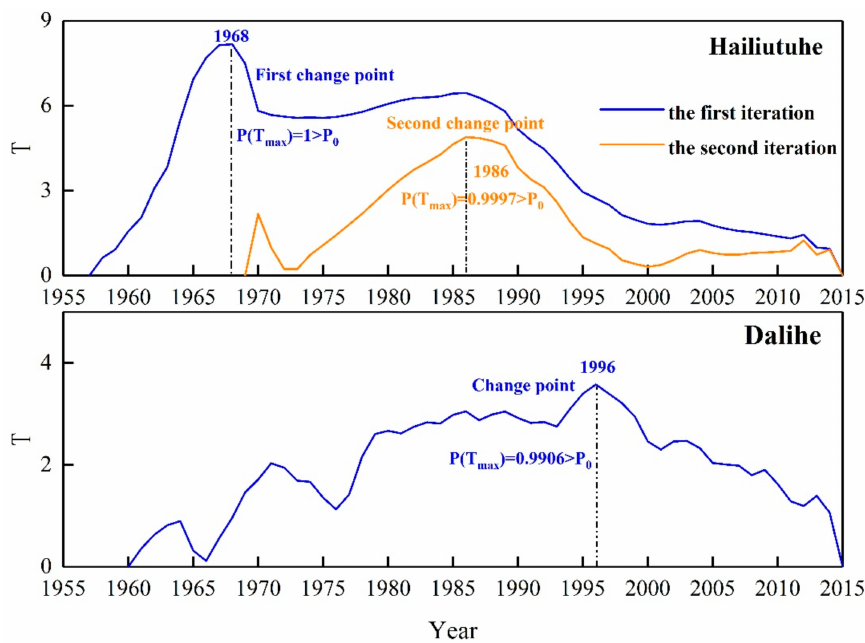
Figure 3. Cumulative anomaly curve of annual baseflow in two